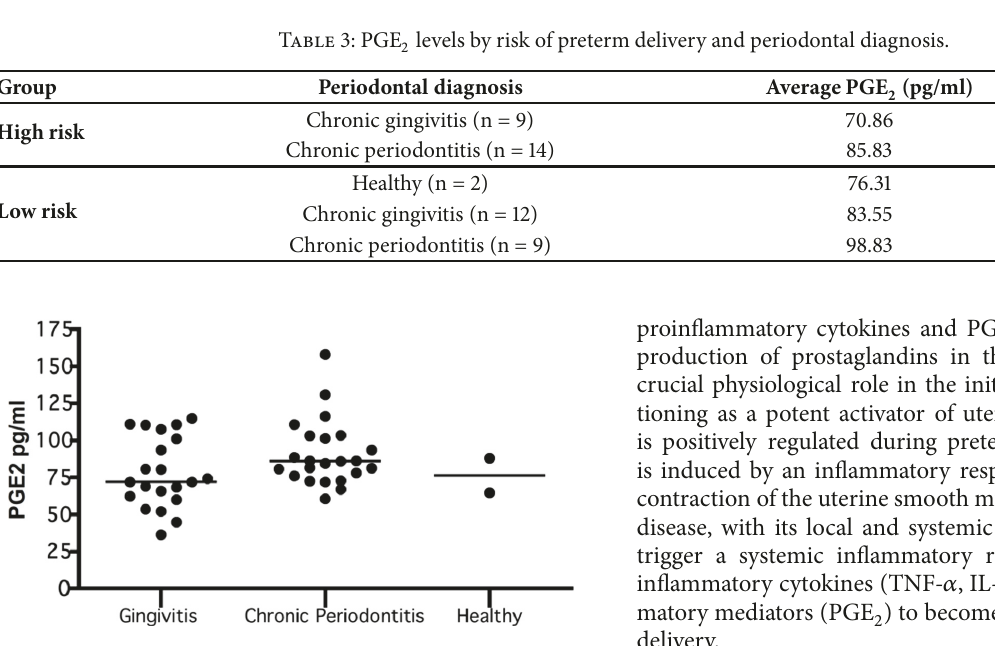
Figure 2: PGE 2 levels by periodontal diagnosis. Expression of PGE 2 in gingivitis (n=21), chronic periodontitis (n=23), and healthy (n=2). The PGE 2 levels was quantified by ELISA and compared between groups by a bivariate analysis. The data are represented by the median for each